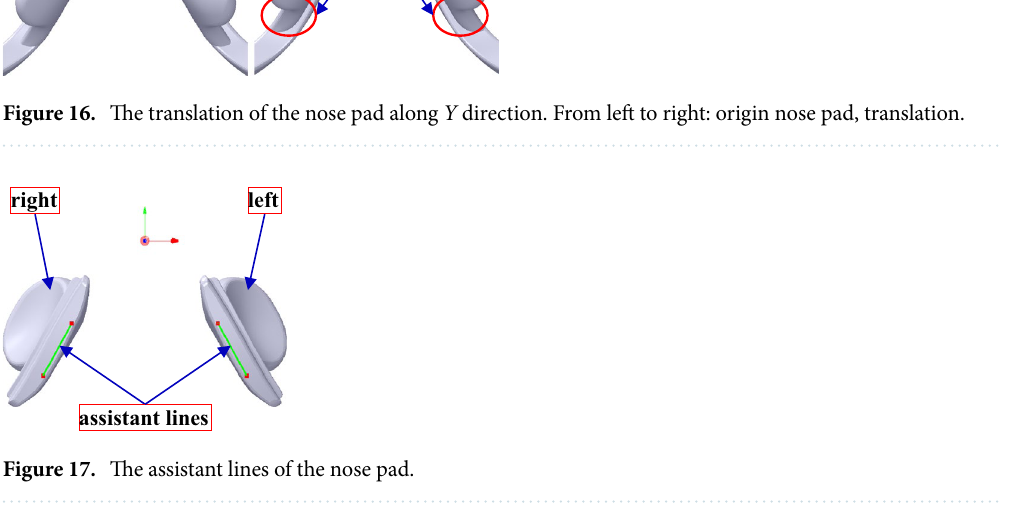
different distances at intersection